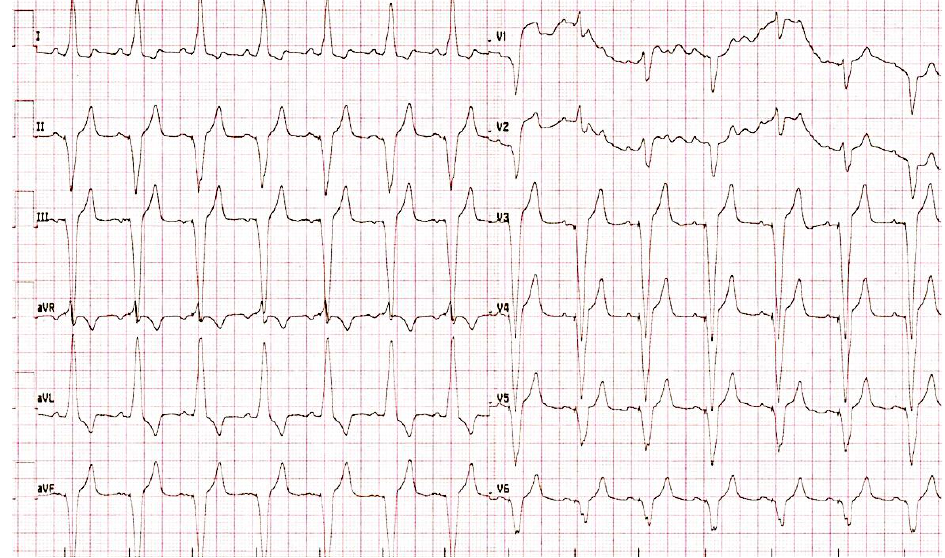
Figure 3. ECG taken based on the routine check-up several months after pacemaker implantation with 100% atrial synchronized ventricular pacing.